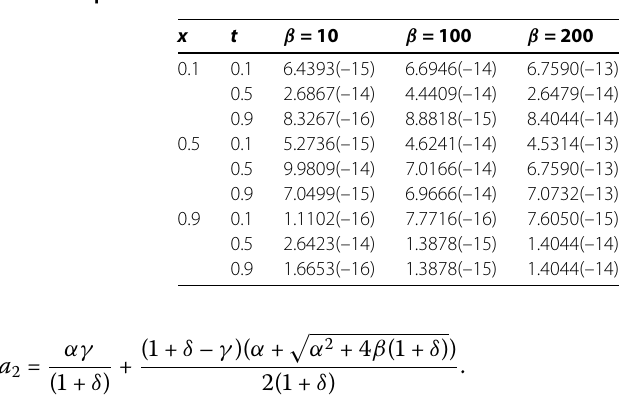
Table 11 Example 4: Case 4.2: Maximum absolute